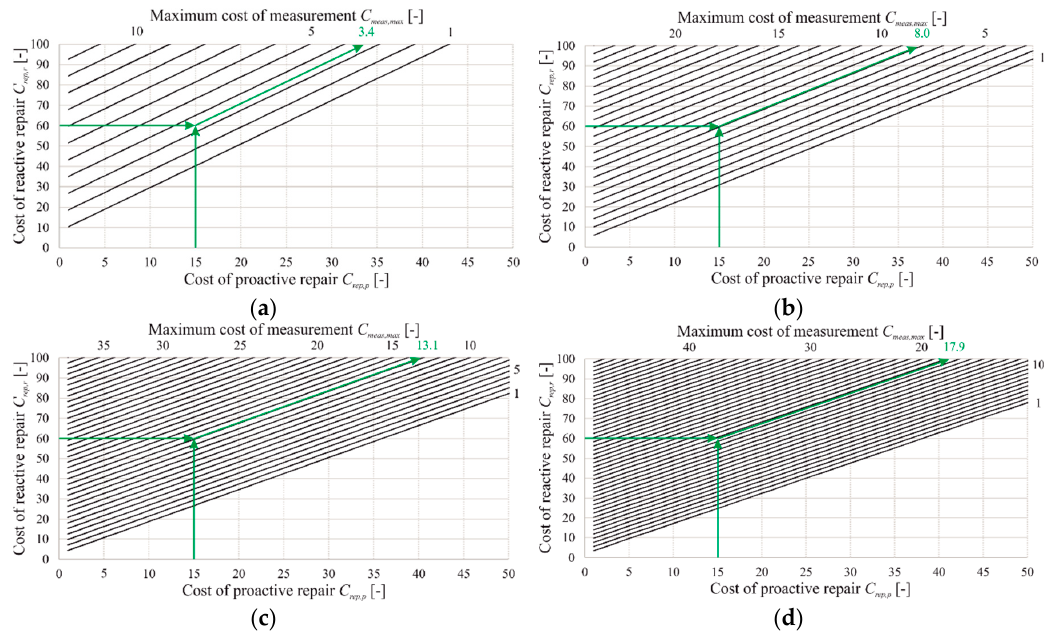
Figure 2. Maximum cost-effective value of measurement, C meas,max , expressed for different costs of preventive and reactive repair; for probability of depassivation: ( a ) P dep = 0.2; ( b ) P dep = 0.4; ( c ) P dep = 0.6; ( d ) P dep = 0.8.